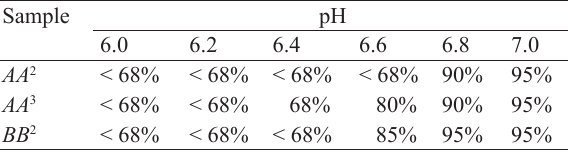
Table 5 Thermal stability of reconstituted dried milk from cows with different CSN3 genotypes by alcohol test